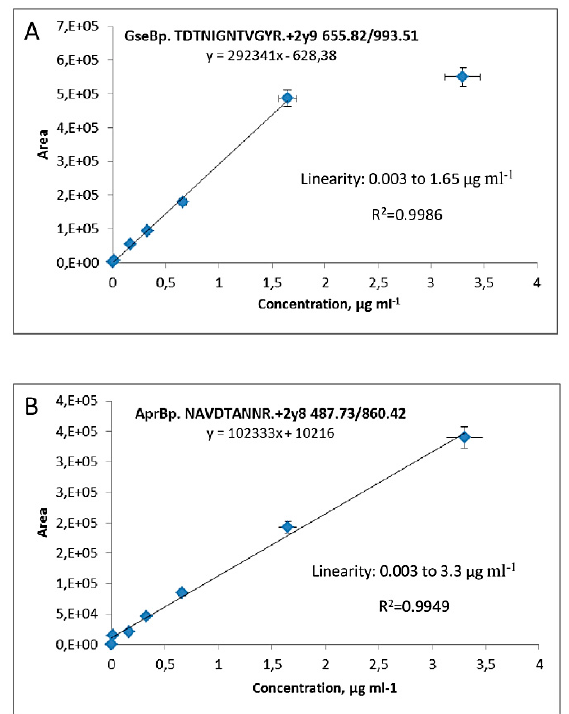
Figure 2. Calibration curve for serine proteases GseBp and AprBp by MRM transitions. The calibration plot for the selected transitions for ( A ) GseBp m / z 655.82 to m / z 993.51 of TDTNIGNTVGYR; ( B ) AprBp transition m / z 487.73 to m / z 860.42 NAVDTANNR. Exhibited linearity up to 1.65 µ g mL − 1 for